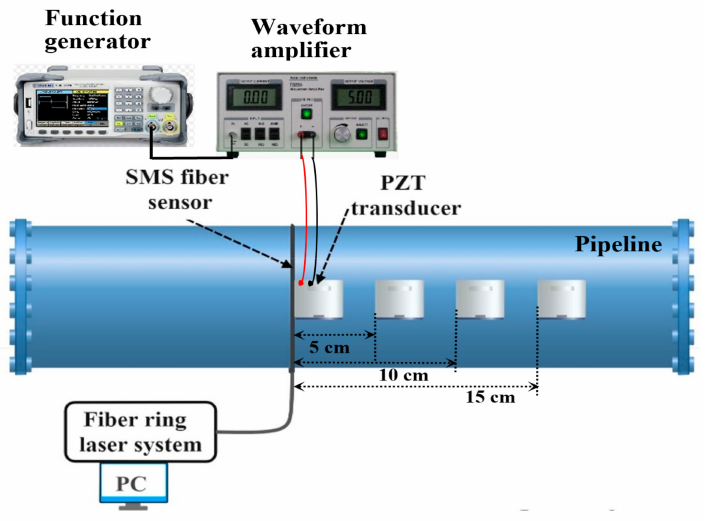
Figure 7. Schematic illustration of the pipeline installed with a proposed vibration sensor system.